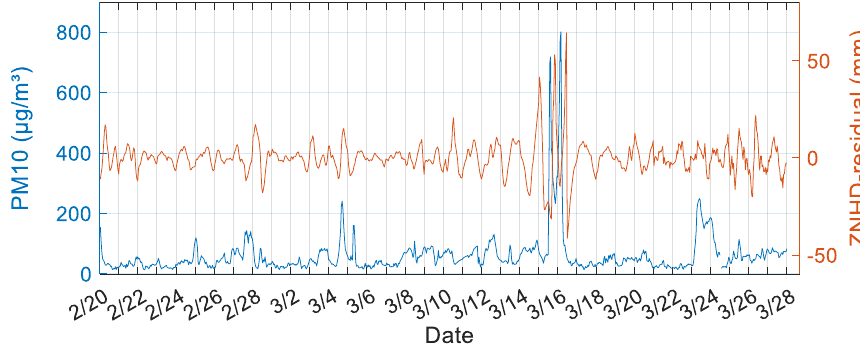
Figure 9. Variations in the PM10 and the ZNHD residual at CHAN station.